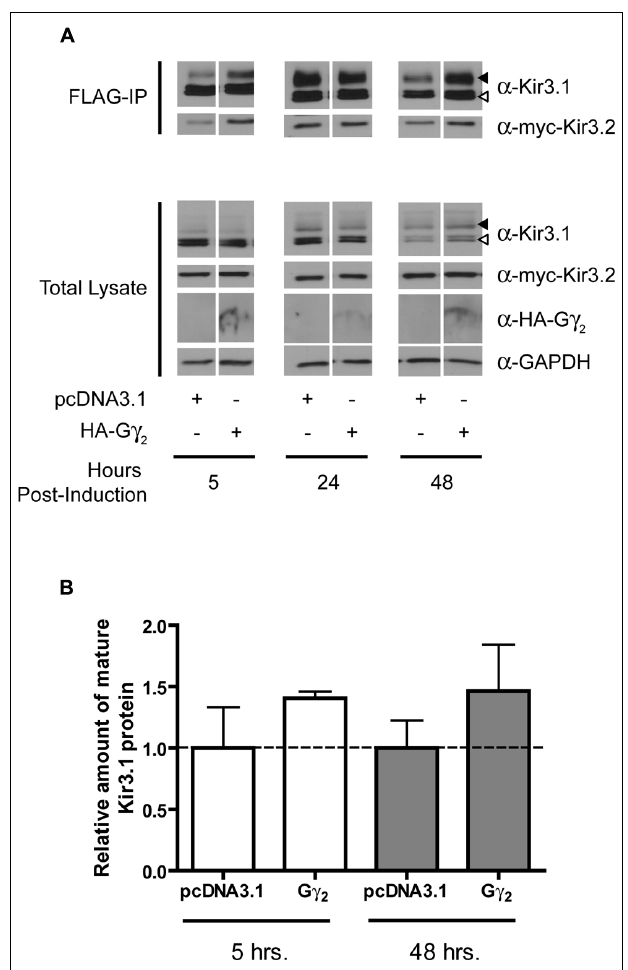
FIGURE 5 | Overexpression of G γ 2 stabilizes the mature form of Kir3.1. (A) Flp-InTrex FLAG-Kir3.1 cells were transfected with HA-G γ 2 and myc-Kir3.2.The cells were subsequently induced to express FLAG-Kir3.1 with 1 μ g/mL of tetracycline for 30 min and chased for 5, 24, or 48 h. Cells were lysed and FLAG-Kir3.1 was immunoprecipitated as described above. Upper panel: samples were analyzed by western blot to detect levels FLAG-Kir3.1 and myc-Kir3.2. Lower panel: total cell lysates showing expression of Kir3.1, Kir3.2, HA-G γ 2 , and GAPDH (as a loading control). Results are representative of three independent experiments.White arrow indicates immature channel proteins while black arrow indicates correctly processed Kir3.1. (B) Densitometric analysis of results obtained above. There is a trend in the effects of G γ 2 expression at 48 h, which is reflected in the western